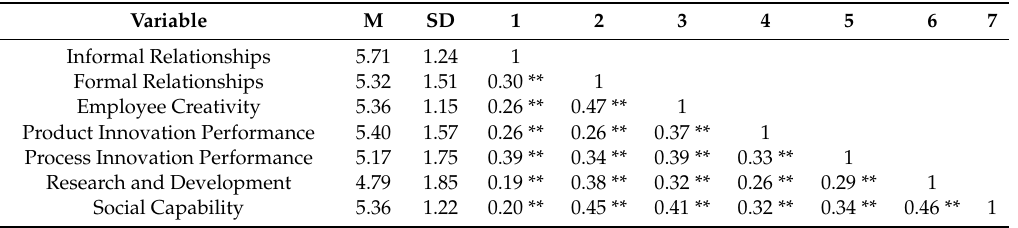
Table 3. Descriptive statistics and Pearson correlations